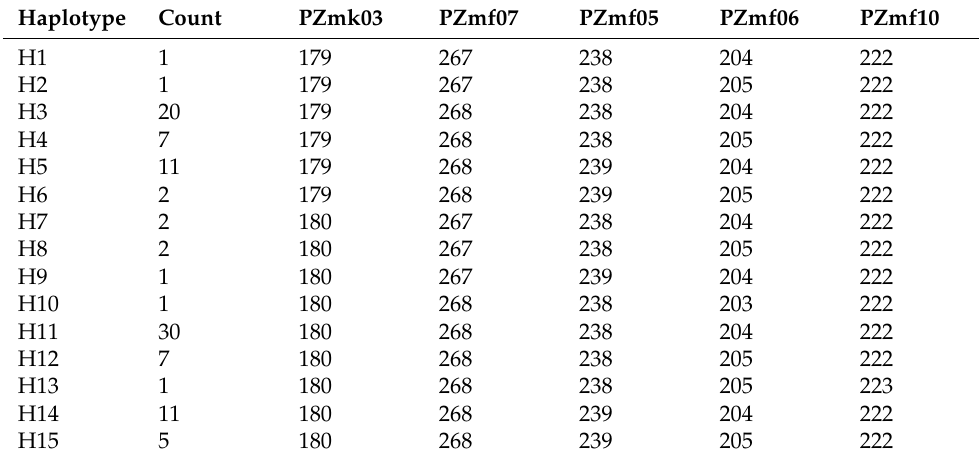
Figure 2. Median-joining haplotype network of 15 haplotypes identified in 102 germplasms. Circle areas are proportional to haplotype frequencies, each filled circle represents a different haplotype, the different colors represent the proportion of germplasms in every haplotype. Table 3. Variation of haplotypes in five cpSSR